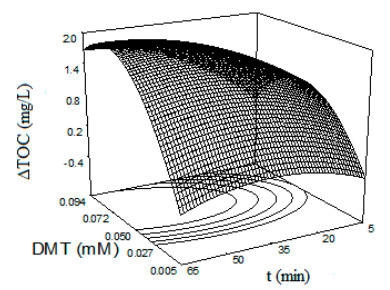
Figure 3. Effects of initial DMT concentration and initial reaction time on the removed TOC concentration.